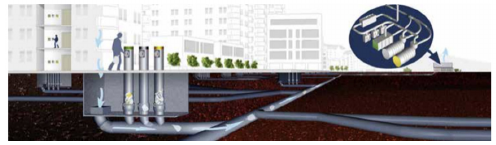
Figure 5. Smart waste collecting system.